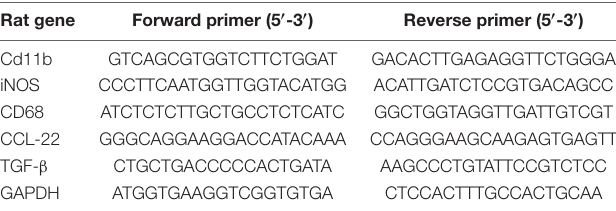
TABLE 1 | Forward and reverse primer sequences for quantitative reverse transcription-polymerase chain reaction (qRT-PCR). Rat gene Forward primer (5 (cid:48) -3 (cid:48) )